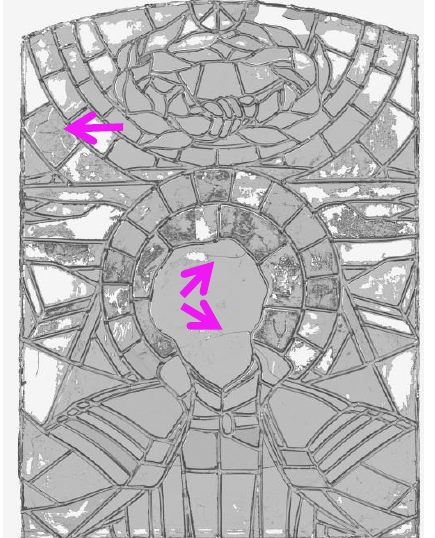
Figure 11. Overview of window 3b from Oswiecim before conservation (inside). Some cracks are marked pink.